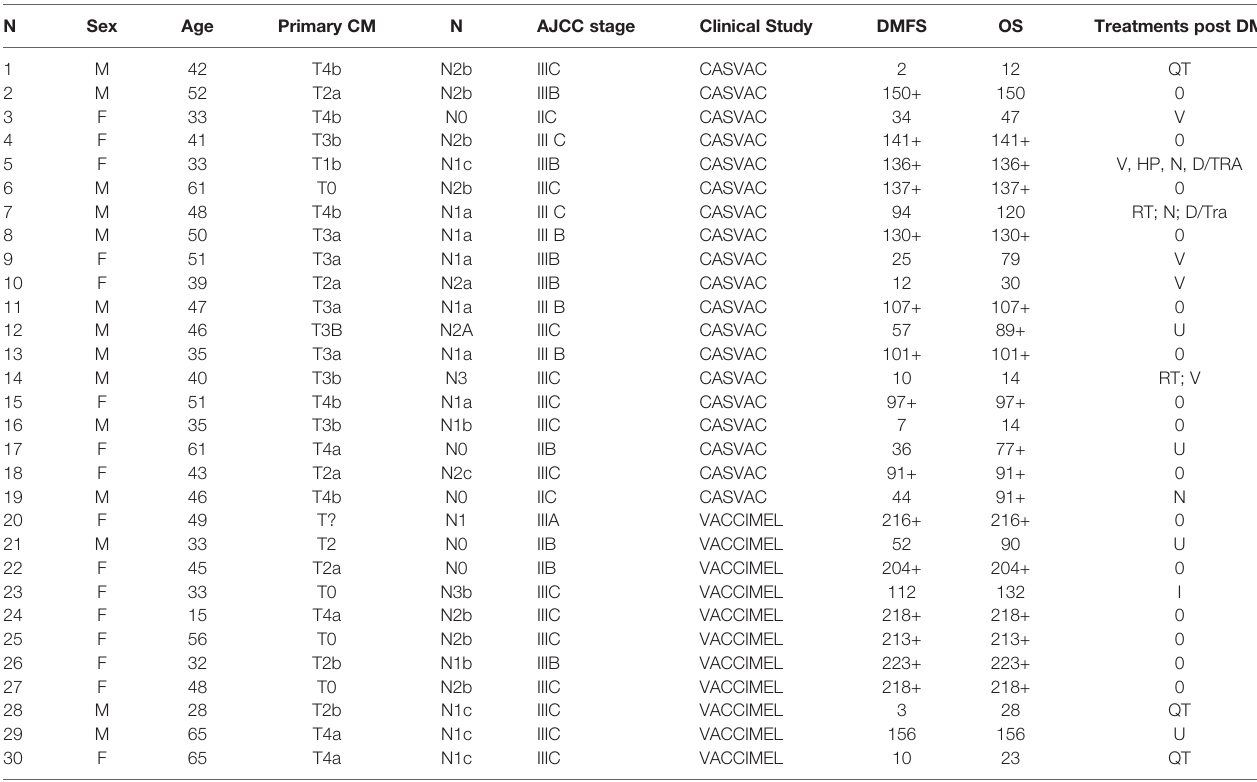
TABLE 2 | Characteristics of patients vaccinated in Phase I and Phase II